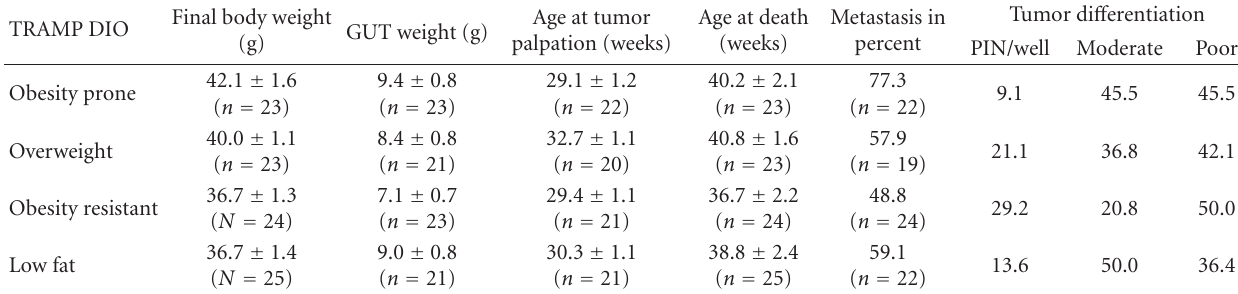
Figure 2: Comparison of TRAMP C-2 tumor cell growth in low-fat fed (open bars N = 40) and high-fat fed (filled bars N = 134) mice. (a) Body weights at 25 weeks of age with animal weights in grams along the y -axis ( t -test P < 0 . 003). (b) Tumor weights at termination with weights in grams shown along the y -axis ( t -test P < 0 . 01). (c) Tumor volume at termination with size in mm cubed shown along the y -axis ( t -test P < 0 . 0007). Bars represent standard error and letters show significant di ff erences. Table 2: Overview of TRAMP DIO